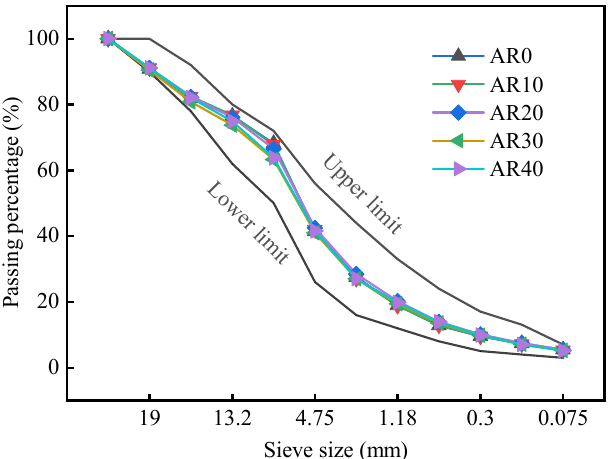
Figure 4. Gradation of designed mixtures.